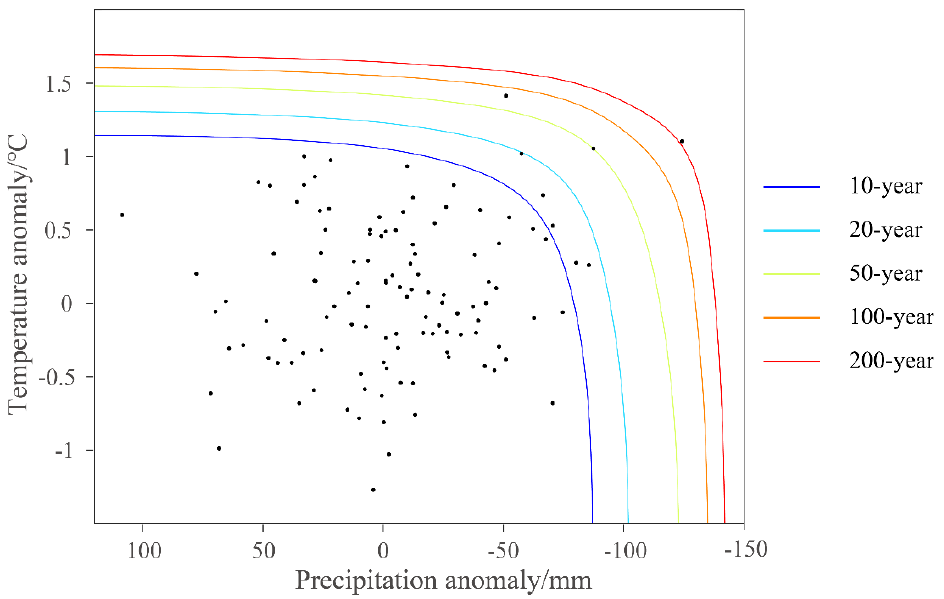
Figure 3. Return period of concurrent events based on CRU data for October-March of 1901–2018 in the study region (10-, 20-, 50-, 100-, and 200-year return periods from the blue to the red isolines, respectively, the same below).